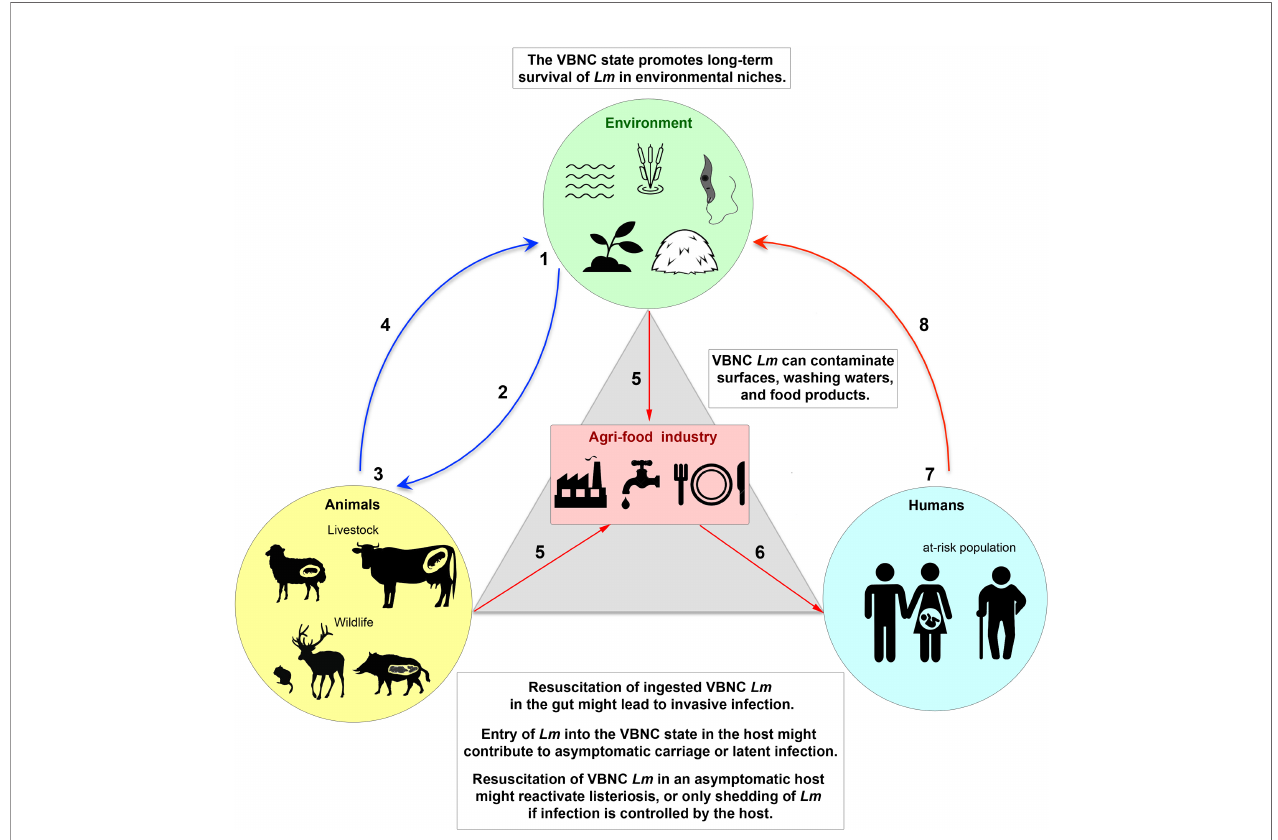
FIGURE 2 | The VBNC state of L. monocytogenes in the One Health continuum . (1) Lm is present in a wide range of environmental ecosystems (e.g., sea, rivers, lakes, soil, plants, fodder, and possibly within unicellular eukaryotes), either in a vegetative culturable state (VC) or in a viable but non-culturable (VBNC) dormant state that allows long-term survival under hostile conditions. (2) VC and VBNC bacteria are ingested by animals, in particular farmed and wild mammals, via food or water. (3) VBNC forms could be reactivated into VC forms in the gut by a resuscitation process. Active VC forms can lead to invasive infection or enter a steady state with the host, resulting in long-term asymptomatic carriage. Entry of bacteria into the VBNC state could contribute to this asymptomatic carriage, by promoting silent colonization of the gastrointestinal tract (gut-liver axis) or the female reproductive system. Resuscitation of dormant VBNC Lm in an asymptomatic host would reactivate a latent infection, leading to listeriosis or, if the infection is controlled by the host, to shedding of Lm into the environment. (4) Excretion of Lm from animals, in feces, abortive products or cadavers, releases the pathogen into the environment, initiating a new cycle. (5) During processing of animal or plant products, Lm can contaminate food industry production lines. Antimicrobial treatments and/or bio fi lm formation favor the appearance of VBNC bacteria and their persistence on surfaces, process wash waters, or in food matrices. VBNC Lm can thus contaminate raw or ready-to-eat foods. (6) Humans become infected by eating foods contaminated with VC or VBNC Lm . (7) As in animals, resuscitation of VBNC Lm in the gut might cause invasive listeriosis, mainly in at-risk populations (pregnant women, the elderly or immunocompromised persons). The VC Lm forms might also switch to the VBNC state in tissues, resulting in asymptomatic colonization of healthy carriers or a latent infection phase in at-risk individuals. (8) Human shedding of Lm releases the pathogen into the